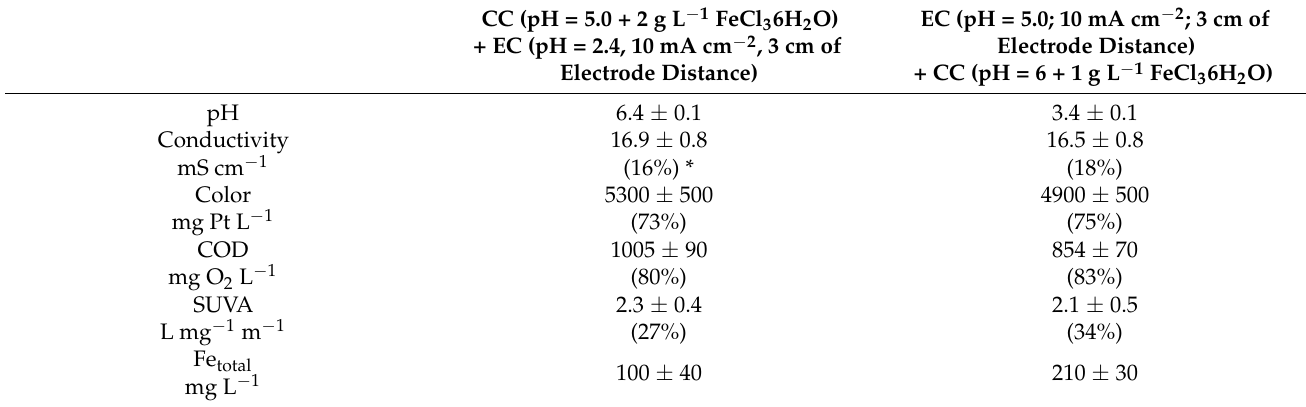
Table 2. Results of both combinations of coagulation pre-treatments (conventional followed by electro-coagulation and vice